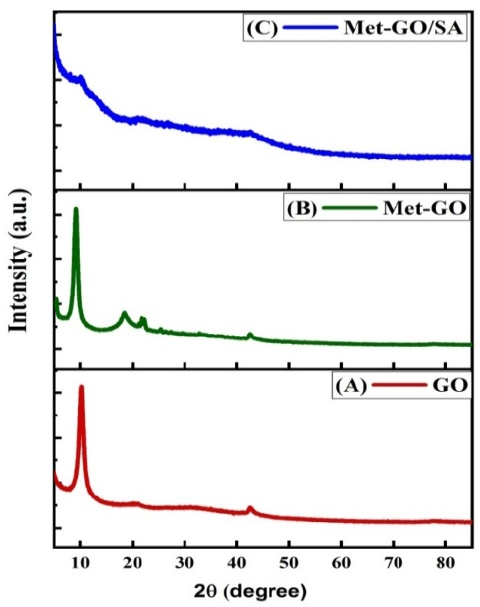
Figure 3. XRD patterns of ( A ) GO, ( B ) Met-GO and ( C ) Met-GO/SA. Here, the d-spacing was also calculated by the Bragg’s Equation (4) [47]: